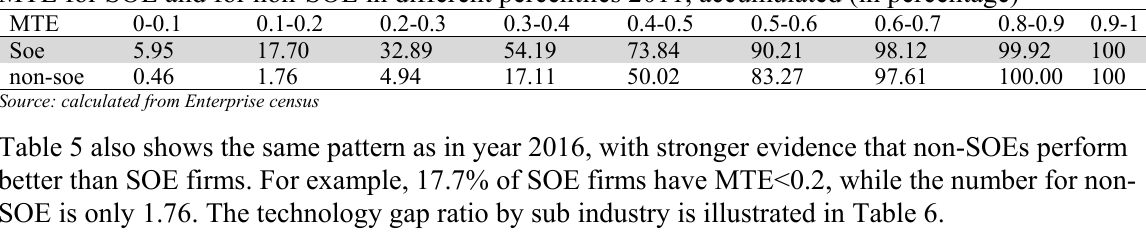
Fig. 2. The MTE for SOE and for non-SOE firms in 2011